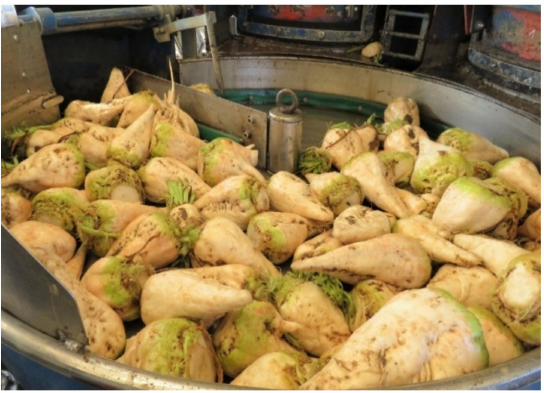
Figure 2. Sugar beet beets after the washing step and at the time of scoring RRCR in the harvester.